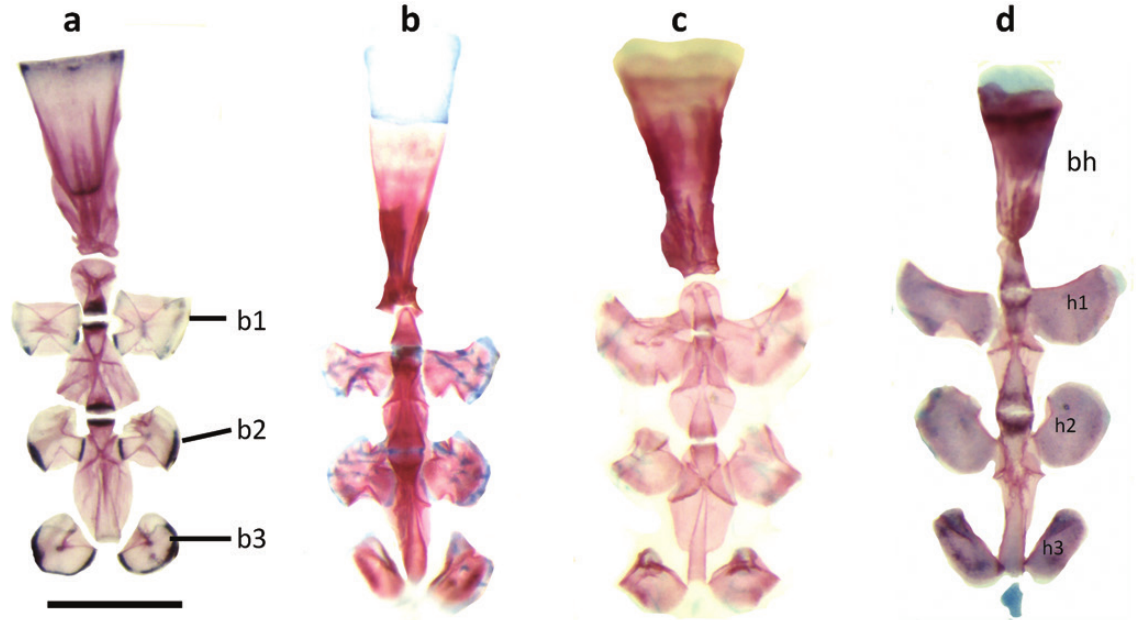
Fig. 6. Dorsal and partial view of ventral gill arches of a. Papiliolebias bitteri , b. Cynopoecilus melanotaenia , c. Ophthalmolebias constanciae , d. Austrolebias juanlangi ; b = basibranchial series, bh = basihyal, h = hypobranchial series. Scale bar = 1